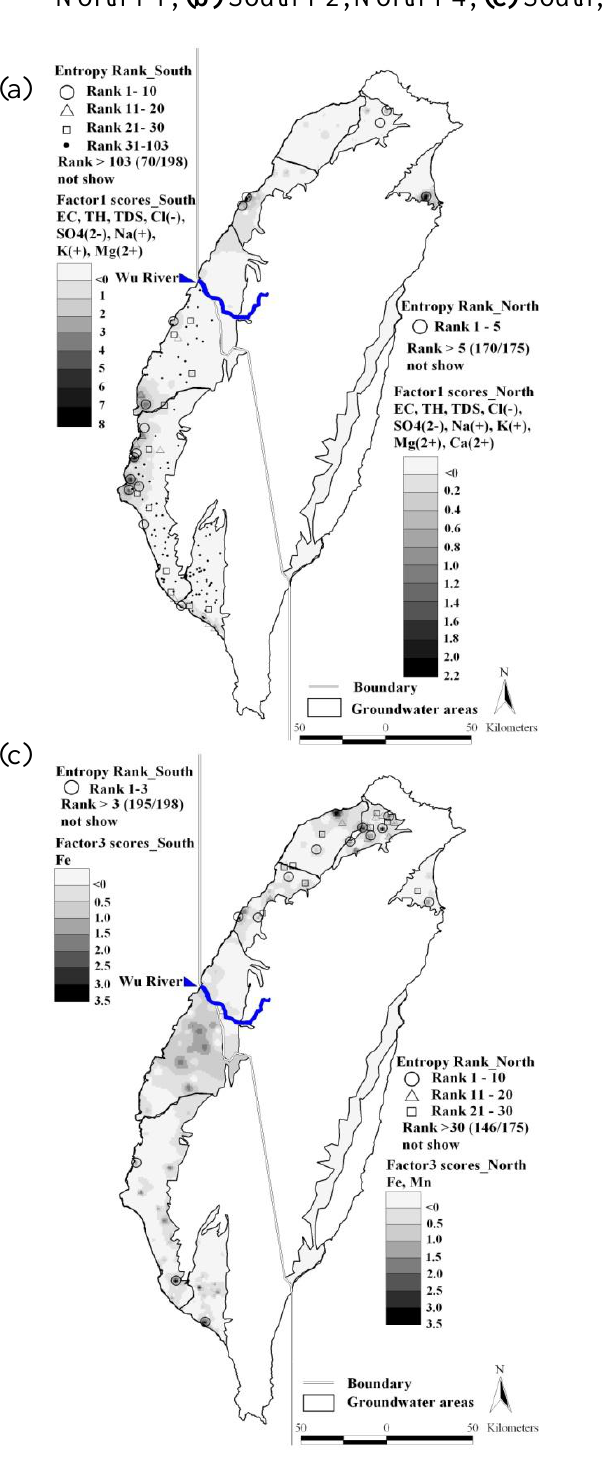
Figure 4. Overlay map of factor scores and information entropy values: (a)